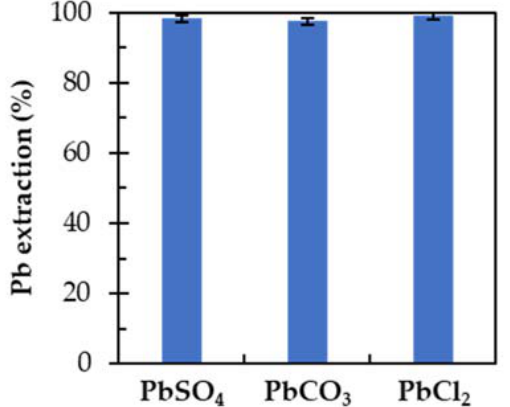
Figure 4. Extraction efficiency of lead minerals with 500 mM EDTA after 24 h.